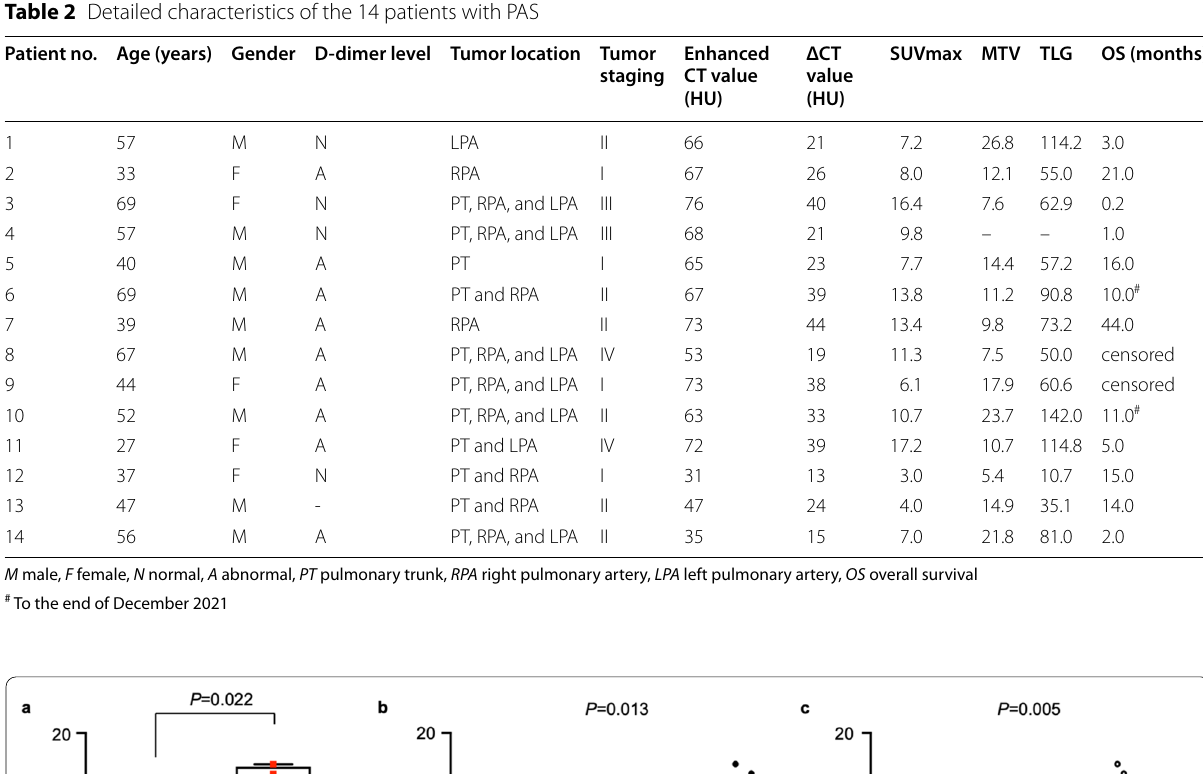
0.022). The correlation of SUVmax with enhanced CT ( b , =